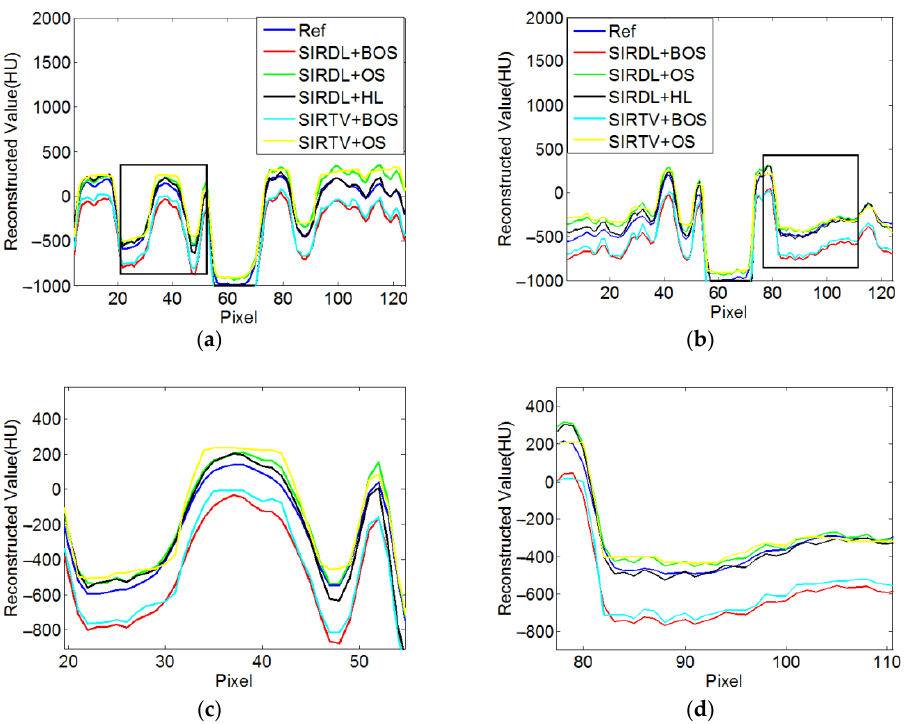
Figure 7. Profiles plots of ROIs reconstructed from 1160 views in Figure 6: ( a ) Horizontal central line; ( b ) vertical central line; ( c ) local enlargement of rectangle in ( a ); ( d ) local enlargement of rectangle in ( b ).